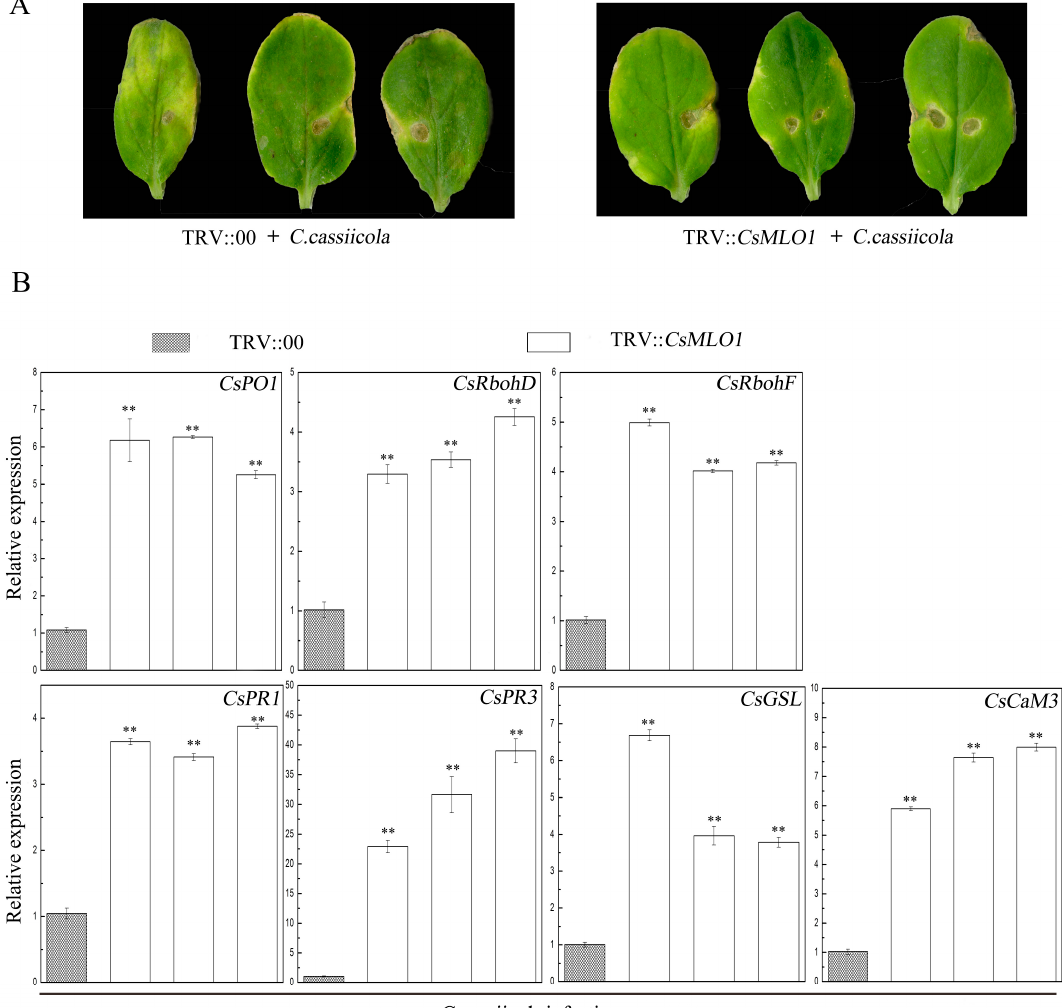
Figure 11. Identification of disease resistance in the empty vector control and CsCsMLO1 silencing in cucumber cotyledons. ( A ) Phenotype of the cucumber cotyledons after C. cassiicola challenge. ( B ) Expression analysis of the CsRbohD , CsRbohF , CsPO1 , CsPR1 , CsPR3 , CsGSL and CsCaM3 (cucumber Calmodulin) genes were determined via RT-qPCR in CsMLO1 -silencing cucumber cotyledons 5 d after C. cassiicola inoculation. Data are the means ± standard deviations from three biological experiments, and each column represents a sample containing three cucumber cotyledons from different plants. Expression analysis of candidate genes using the 2 −ΔΔ Ct method. The asterisks indicate a significant difference (Student’s t test, ** P < 0.01).